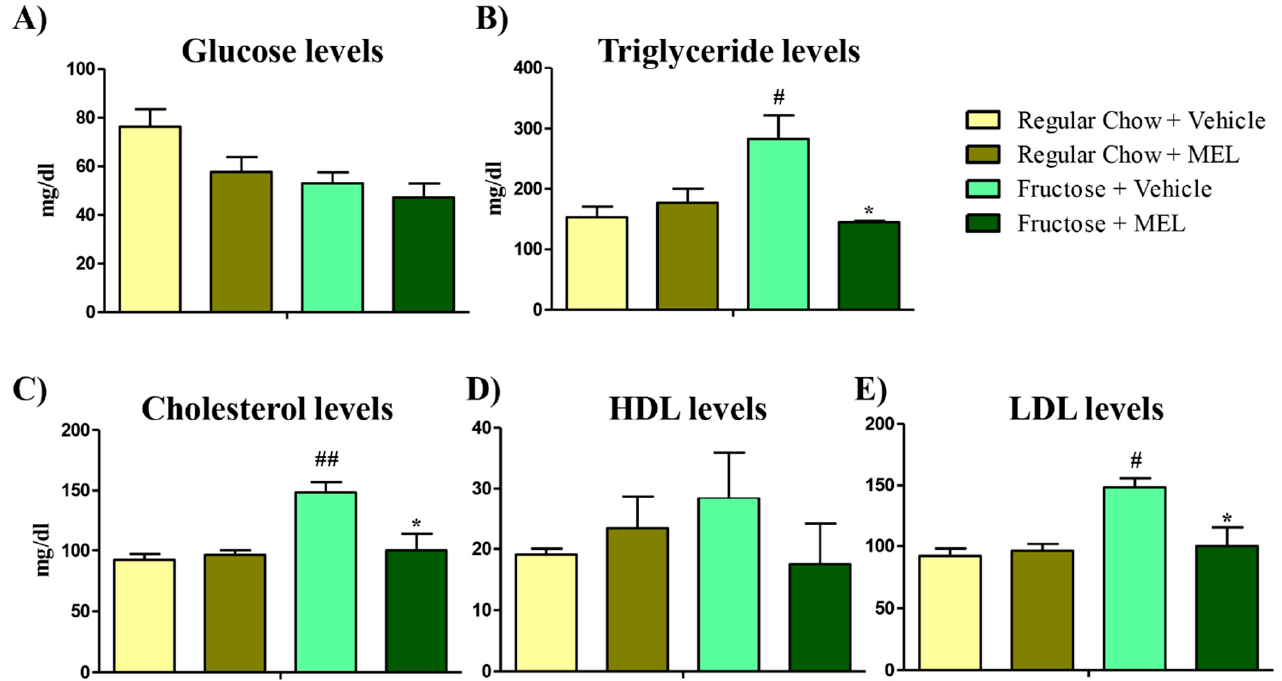
Figure 1. Fructose diet produces an imbalance in serum lipid markers that is ameliorated by melatonin. ( A ) Glucose levels in serum were measured in mg/dl from hamsters fed with regular chow or fructose with or without melatonin treatment (25 µ g of melatonin for 15 days). ( B ) Triglycerides, ( C ) Cholesterol, ( D ) HDL, and ( E ) LDL levels in serum were measured in mg/dl from hamsters fed with regular chow or fructose with or without melatonin treatment. Bars are mean ± SEM. * p < 0.05 (differences caused by melatonin treatment) and # p < 0.05, ## p < 0.001 (differences caused by diet).